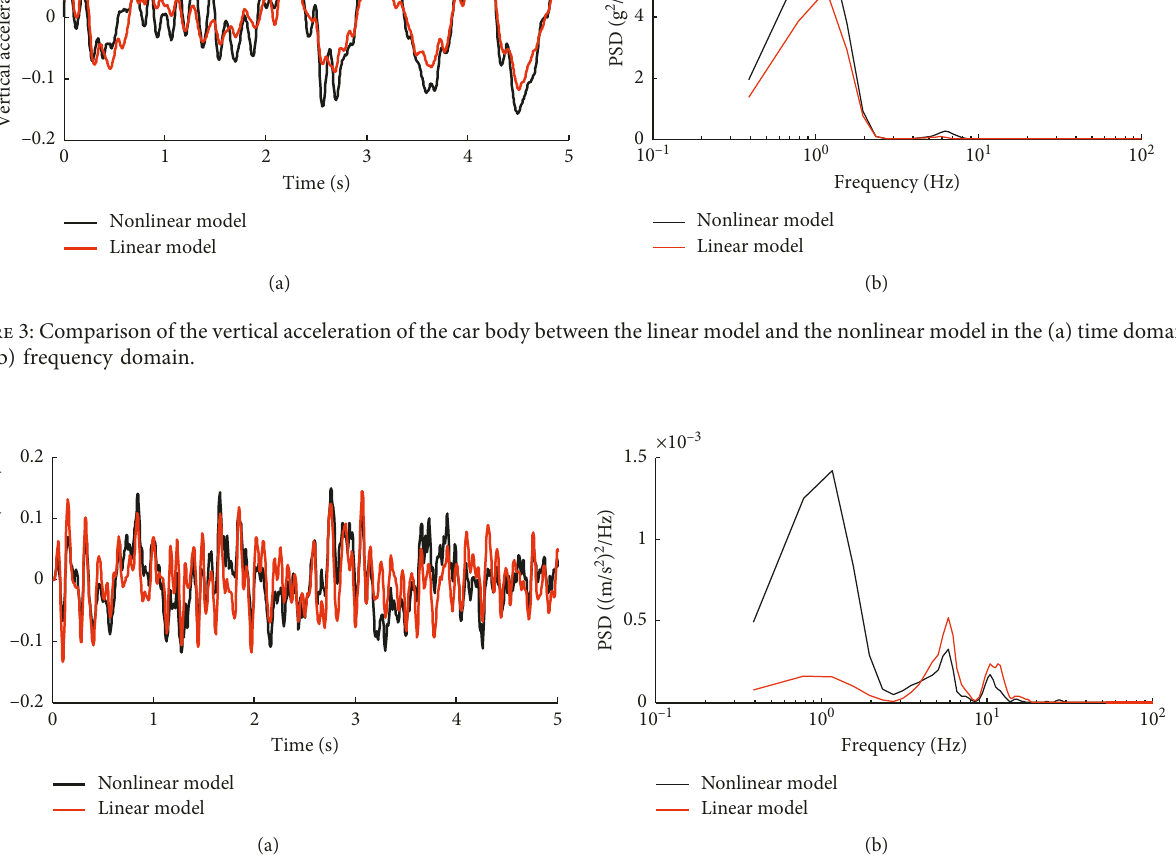
Figure 4: Comparison of the lateral acceleration of the car body between the linear model and the nonlinear model in the (a) time domain and (b) frequency domain.